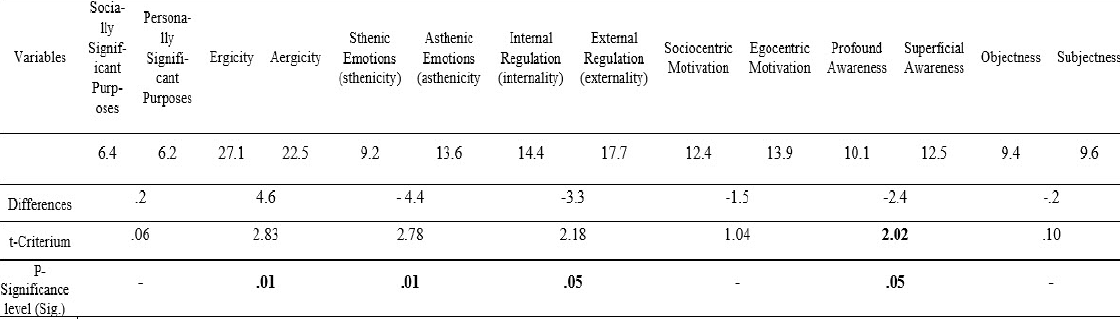
level of perseverance